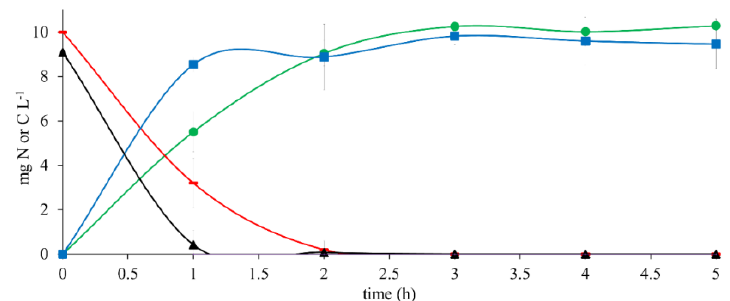
Figure 1. Kinetic profile of substrate consumption and product generation in denitrifying reference assays with 10 mg CH 3 COO − -C L −1 at C N −1 of 1.1. ( ▬ ) CH 3 COO − -C, ( ▲ ) NO 3 − -N, ( ● ) HCO 3 − -C, ( ■ ) N 2 .